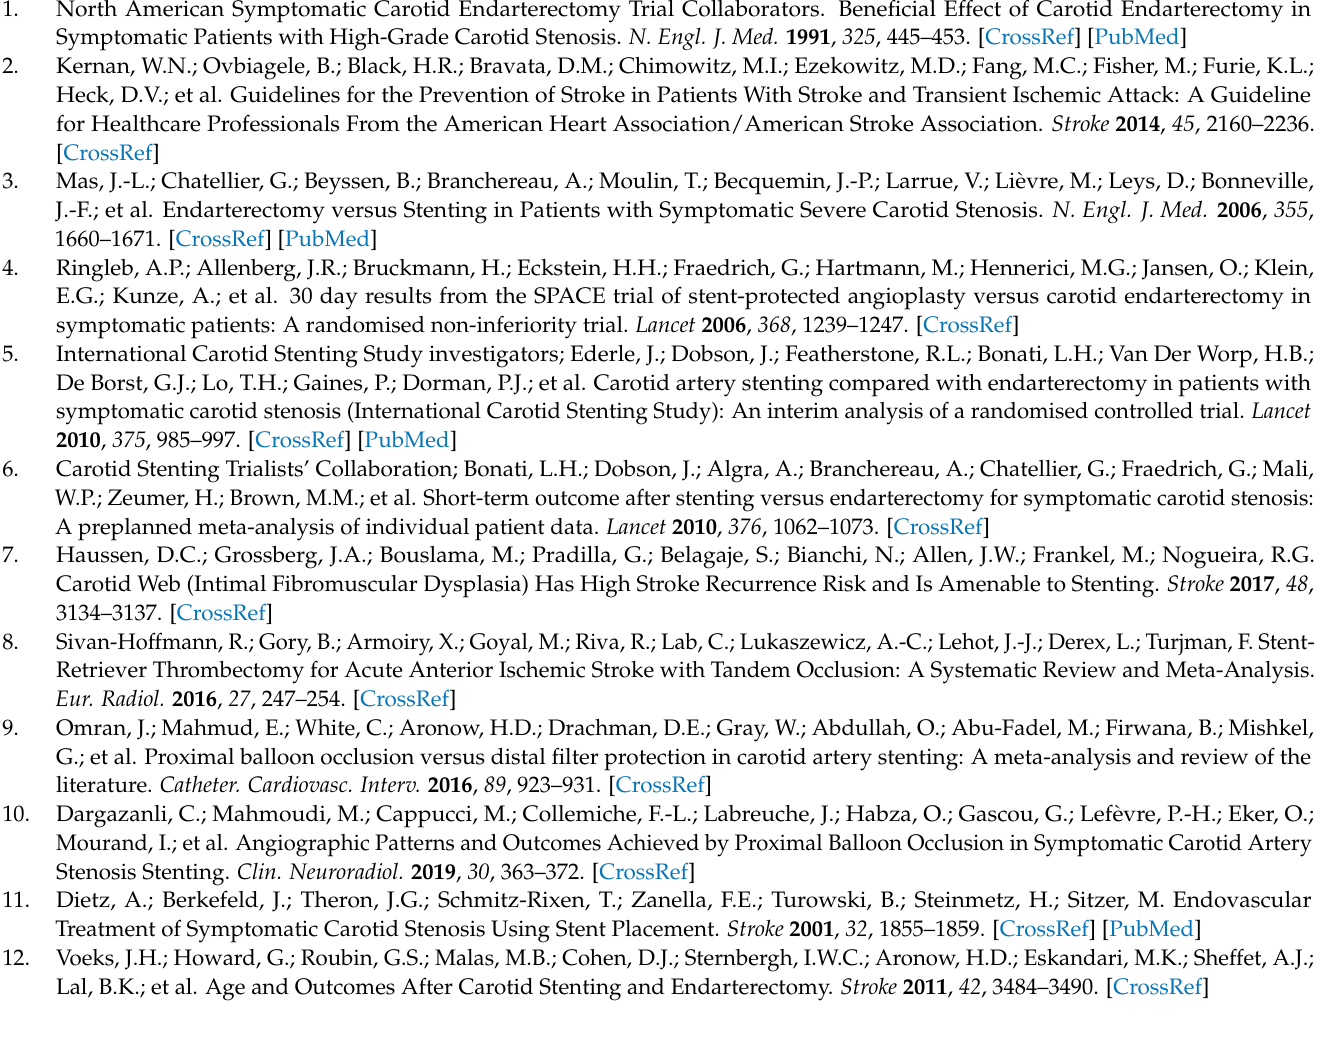
Figure A2. This patient presented right hemiparesis with a symptomatic 75% left ICA stenosis confirmed with angio-MR ( A ) without any ischemic brain lesions on the DWI-MRI performed 8 h from symptom onset ( B , C ), but perfusion MRI showed left sylvian hypoperfusion (TMax > 6 s) ( D ). Carotid artery stenting performed 1 day after symptom onset confirmed the ICA stenosis ( E ) and the stenting was successfully performed ( F ). However, the patient presented pre-procedural hypertension involving strict blood pressure monitoring after the CAS with a target level of <120/80 mmHg. The DWI-MRI performed 25 h from the CAS revealed symptomatic new cerebral lesions (punctiform and >10 mm) in the ipsilateral side ( G , H ) without large intracranial vessel occlusion. Dual antiplatelet medication was continued. However, the 30-h CT performed for a neurologic deterioration revealed an intraparenchymal hemorrhage ( I ) corresponding to a reperfusion